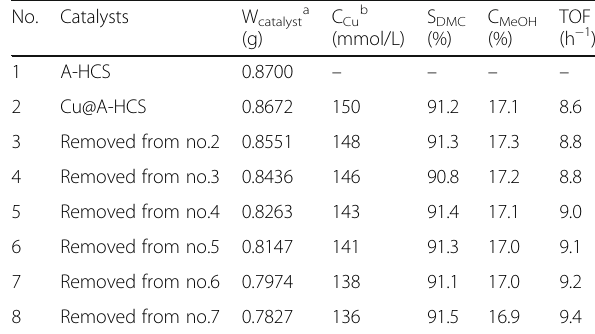
Table 4 Results for recycling of activated Cu@A-HCS catalysts activated with